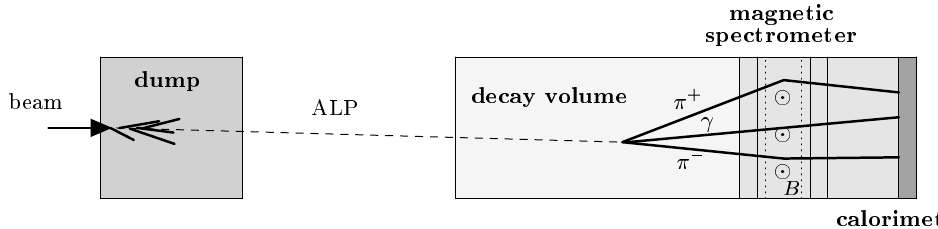
Figure 3 . Schematic view of the experimental setup for the case that the ALP decays via a → π + π − γ